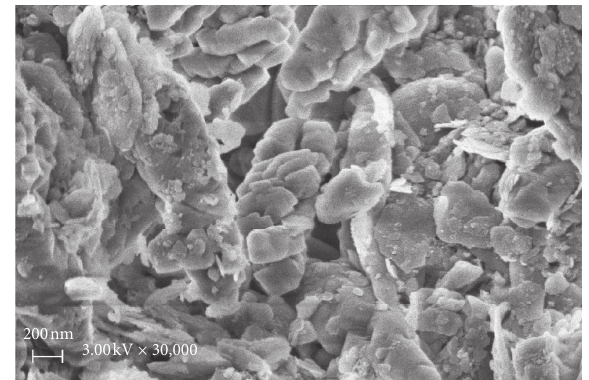
Figure 6: SEM image of 20% calcium carbonate-doped red clay.